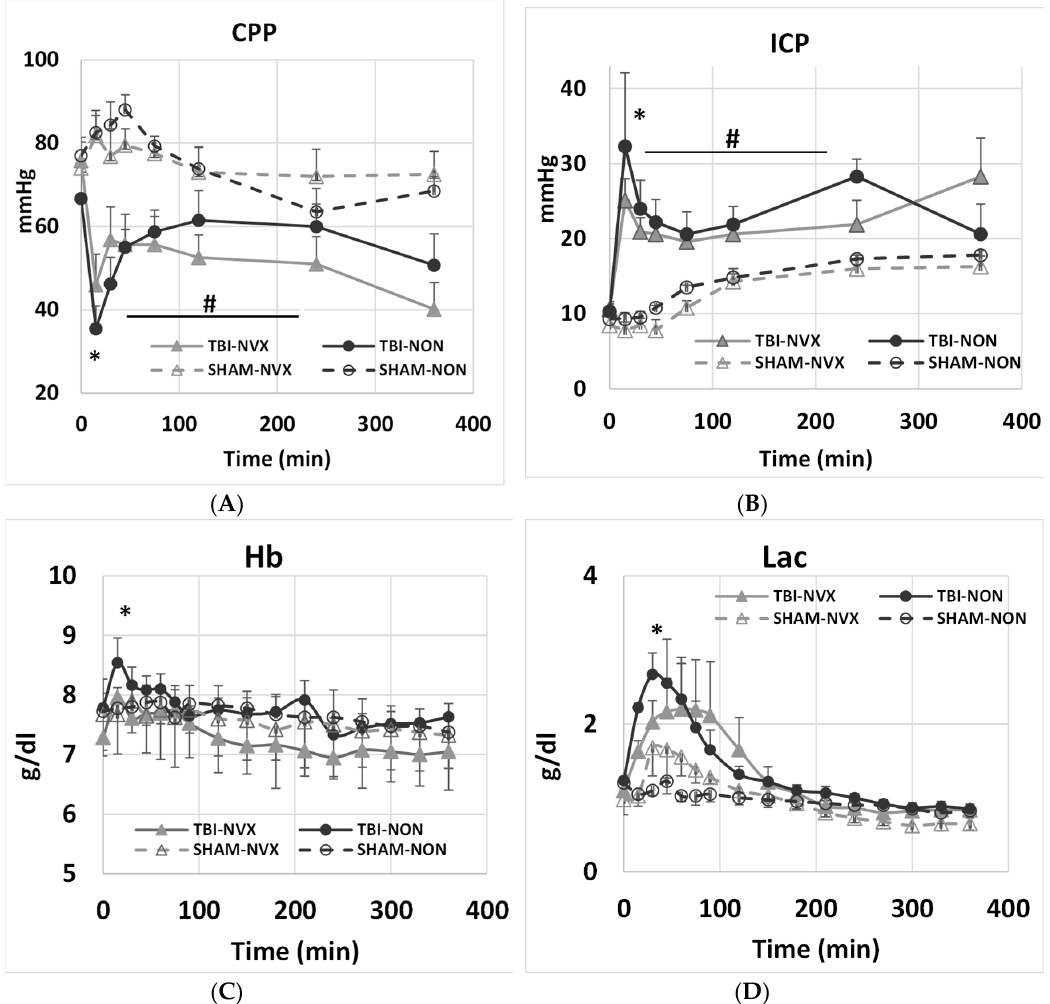
Figure 4. ( A ) Intracranial pressure (ICP) and ( B ) cerebral perfusion pressure (CPP) for the TBI-NVX, TBI-NON, SHAM-NVX and SHAM-NON groups. ( C ) Hb and ( D ) Lactate for the TBI-NVX, TBI-NON, SHAM-NVX and SHAM-NON groups. * p < 0.01; significant difference at T15 between TBI vs. SHAM (combined TBI-NVX and TBI-NON vs. SHAM-NVX and SHAM-NON) indicating the initial physiological effect due to TBI. Mean and standard deviation; SHAM-NON (-- ○ --), SHAM-NVX (-- ∆ --), TBI-NON ( ─ ● ─ ), TBI-NVX ( ─▲─ ). # p < 0.05; significant difference from T15 to T200 for TBI groups.